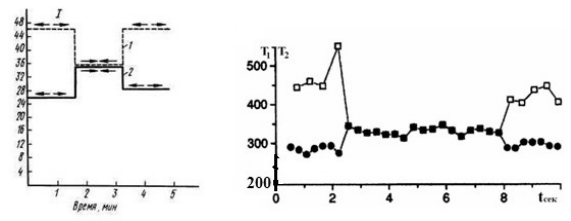
Fig. 3. Interaction of fragments of the pacemaker tissue of the frog's heart on the left; the rhythms of the preparations are 46 and 26 beats / min, the general rhythm is 35 beats / min; the right shows the interaction of two single pacemaker cells. A single rhythm is formed at an intermediate level closer to the rhythm of a cell with a higher